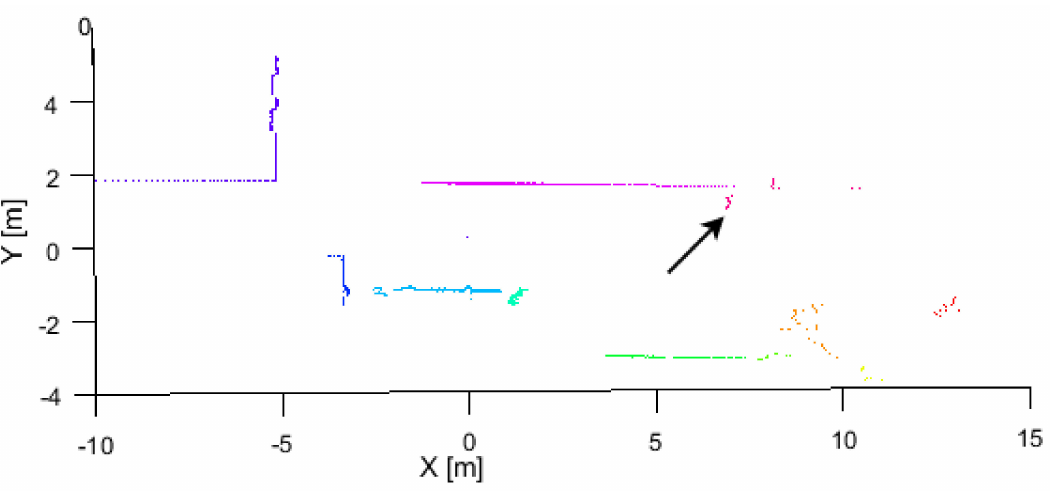
Figure 10. Dynamic object united with wall on one